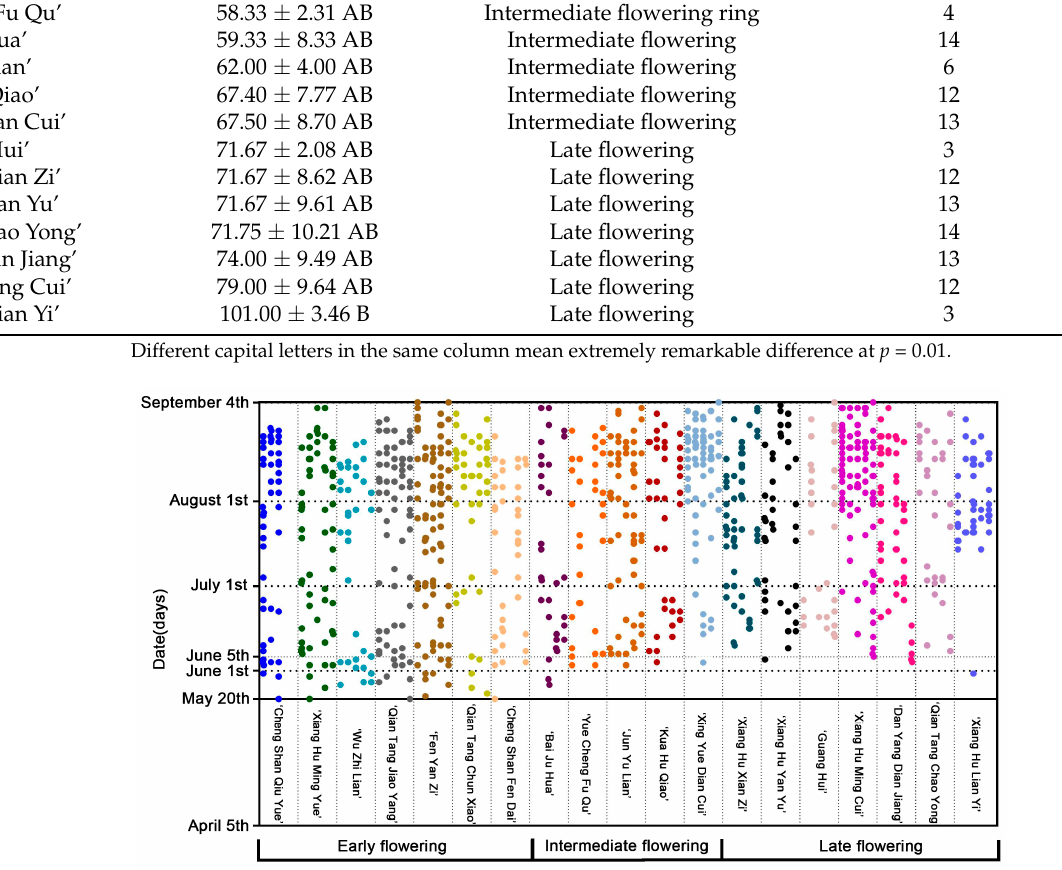
Figure 1. Scatter plots of blooming time of 19 cultivars in